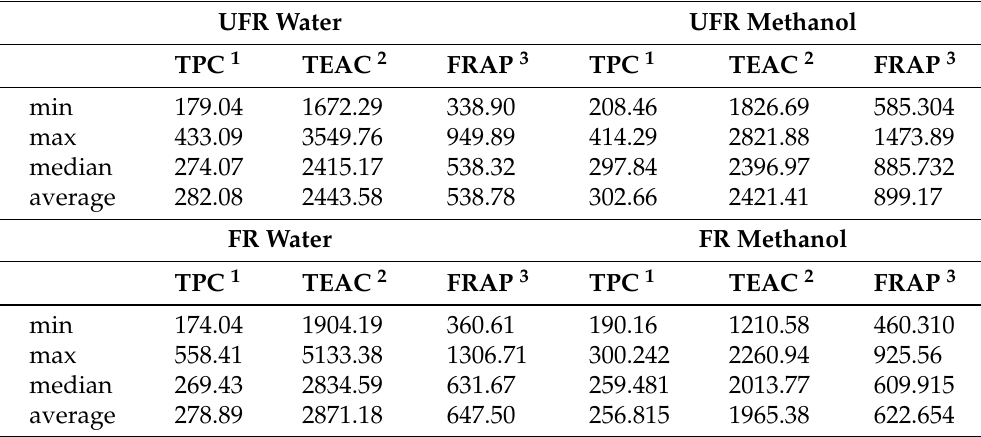
Table 2. Summary statistics for different assay values for the 47 UFR and 51 FR rooibos